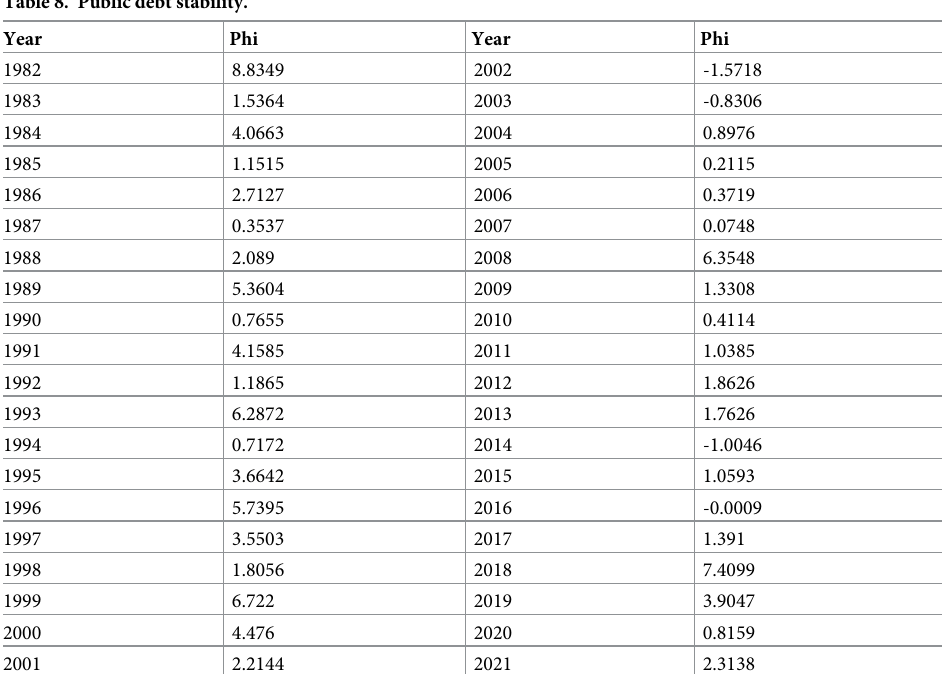
Table 8. Public debt